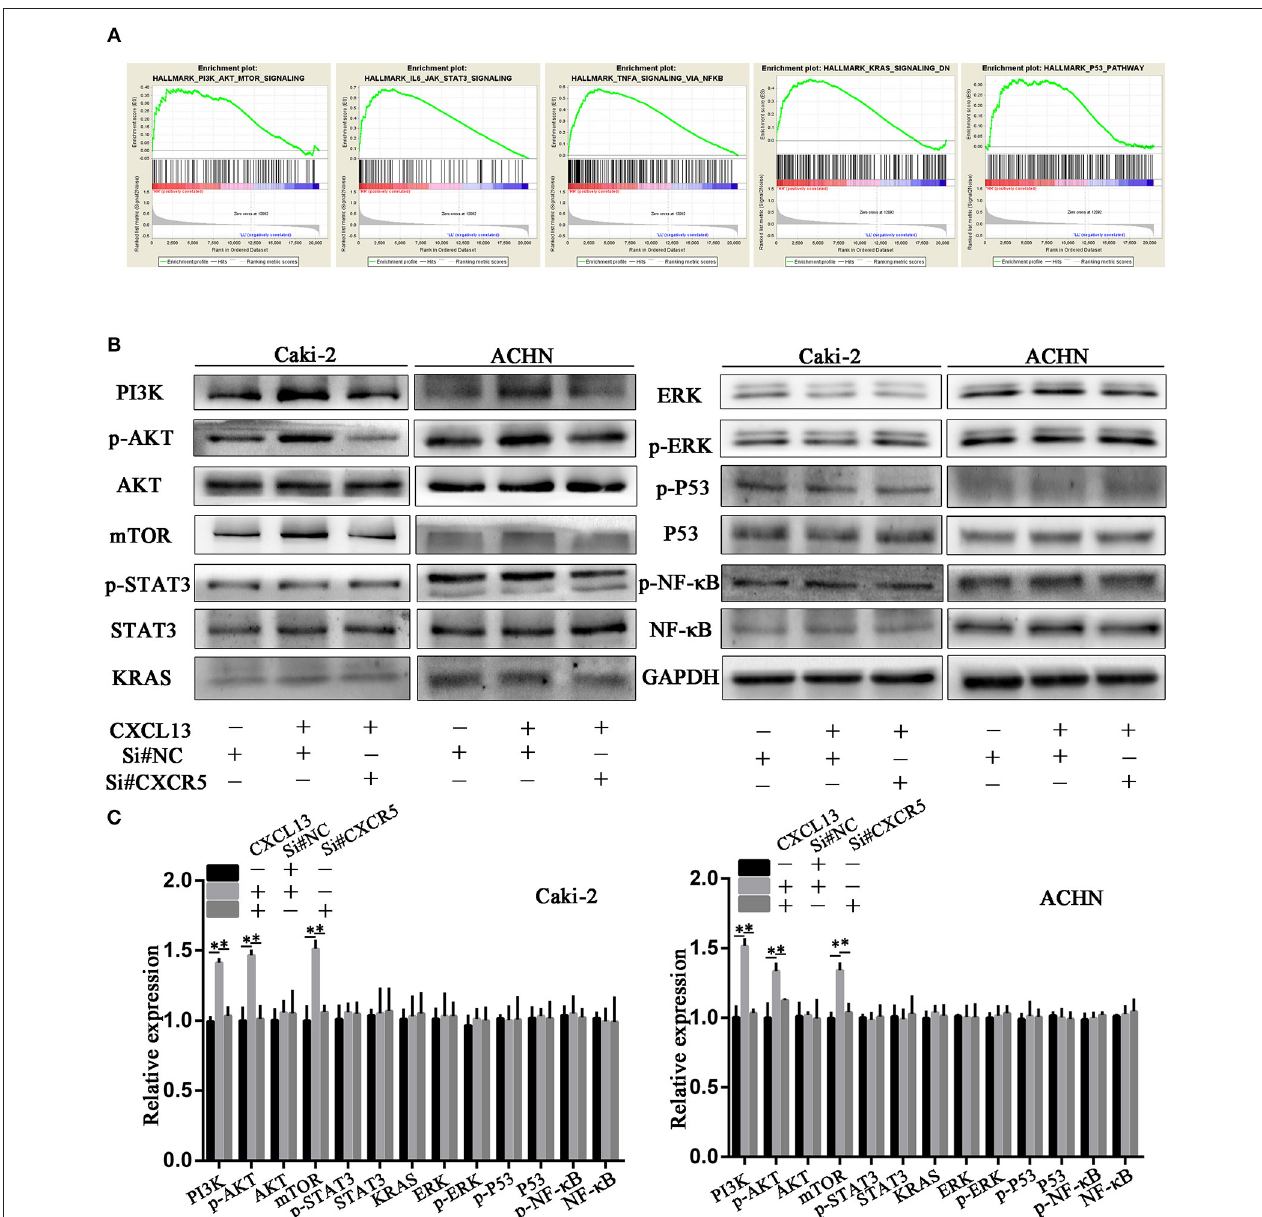
FIGURE 6 | CXCL13/CXCR5 axis promoted ccRCC progression partly through PI3K/AKT/mTOR pathway. (A) GSEA was performed to identify associated pathways between CXCL13 + CXCR5 + and CXCL13 − CXCR5 − ccRCC tissues. PI3K/AKT/mTOR pathway, JAK/STAT3 pathway, TNF- α /NF-kB pathway, KRAS pathway, and P53 pathway were activated in CXCL13 + CXCR5 + ccRCC tissues. (B) Western blotting analysis of these associated pathway in ccRCC cells. The expression of PI3K, p-AKT, and mTOR in ccRCC cells (Caki-2 and ACHN) were upregulated when incubated with CXCL13, and downregulated with CXCR5 knockdown. (C) Relative expression of associated pathway protein in ccRCC cells. GAPDH was used as normal control (Student’s t -test, * P < 0.05).